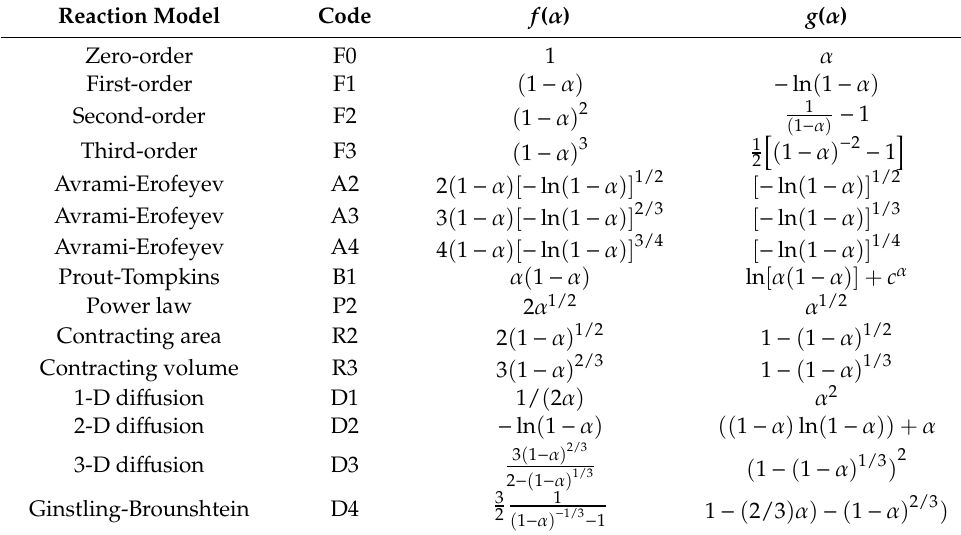
Table 1. Classification of model-fitting kinetic expressions for reaction mechanisms [45].